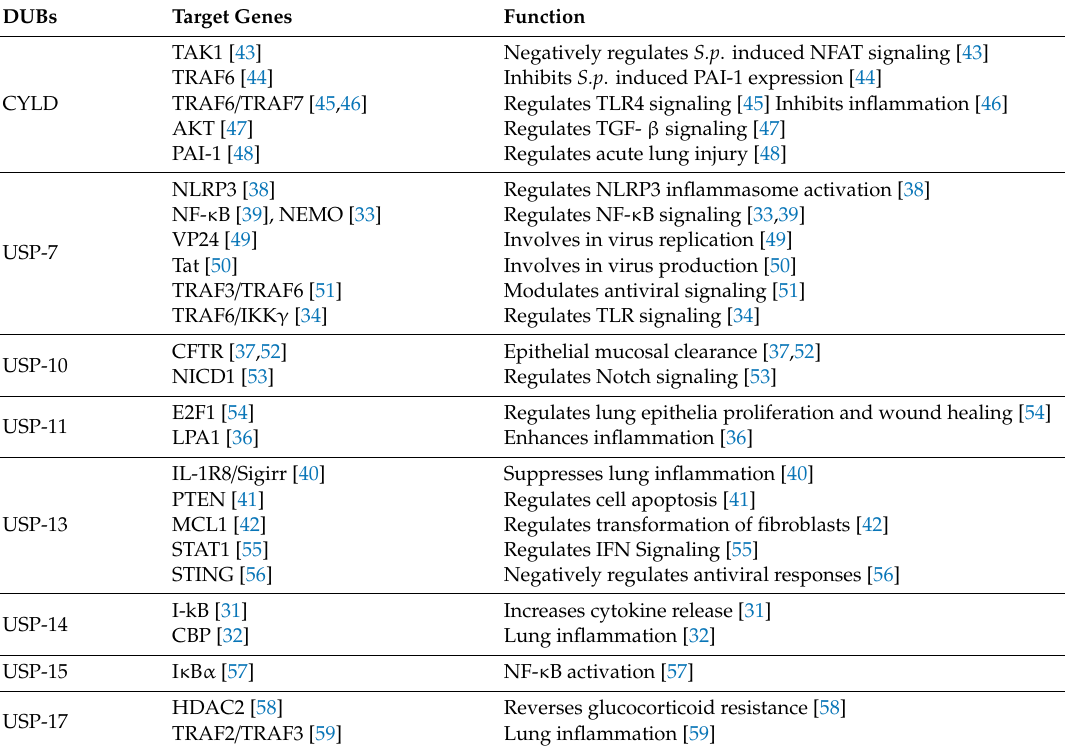
Table 1. The roles of DUBs in ALI /